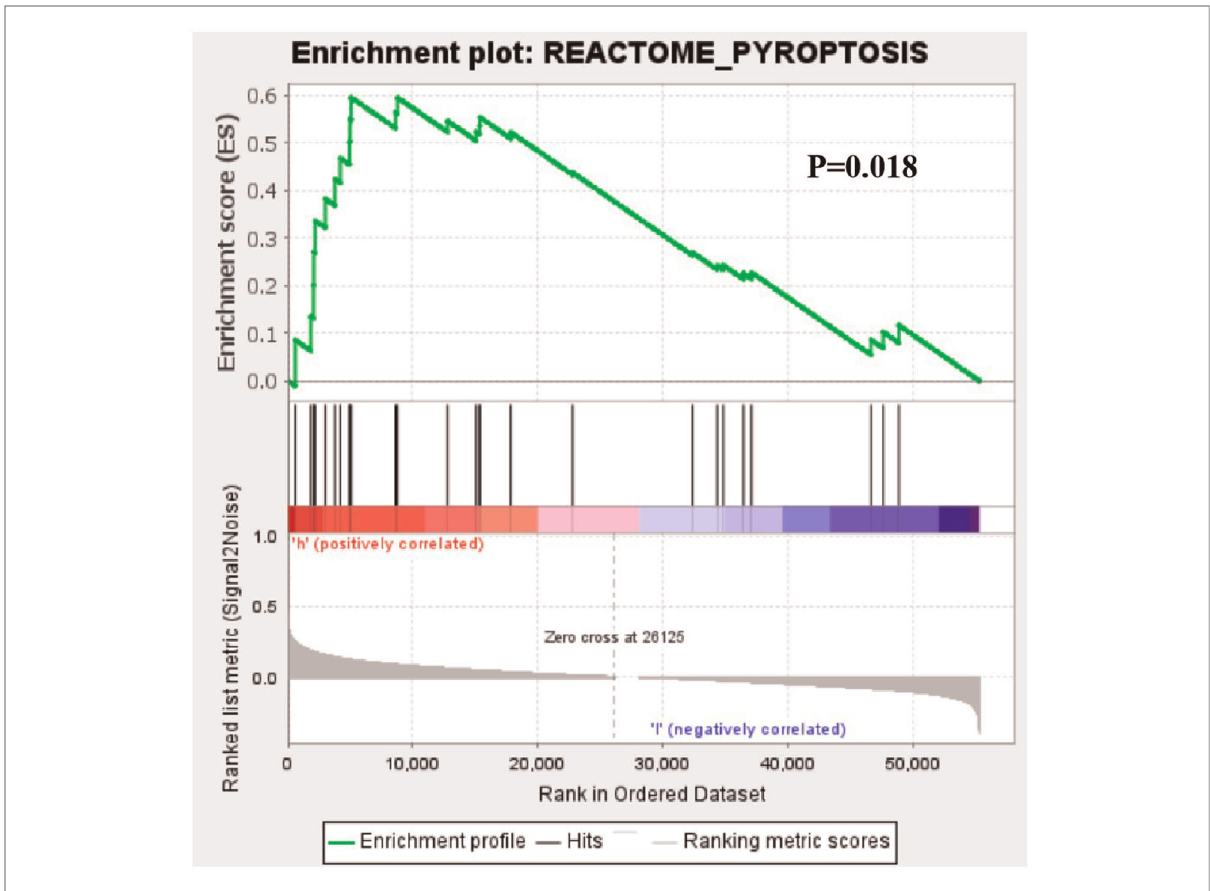
FIGURE 12 Gene set enrichment analysis of the differential expression of the pyroptosis-related lncRNAs between low-risk and high-risk patients with